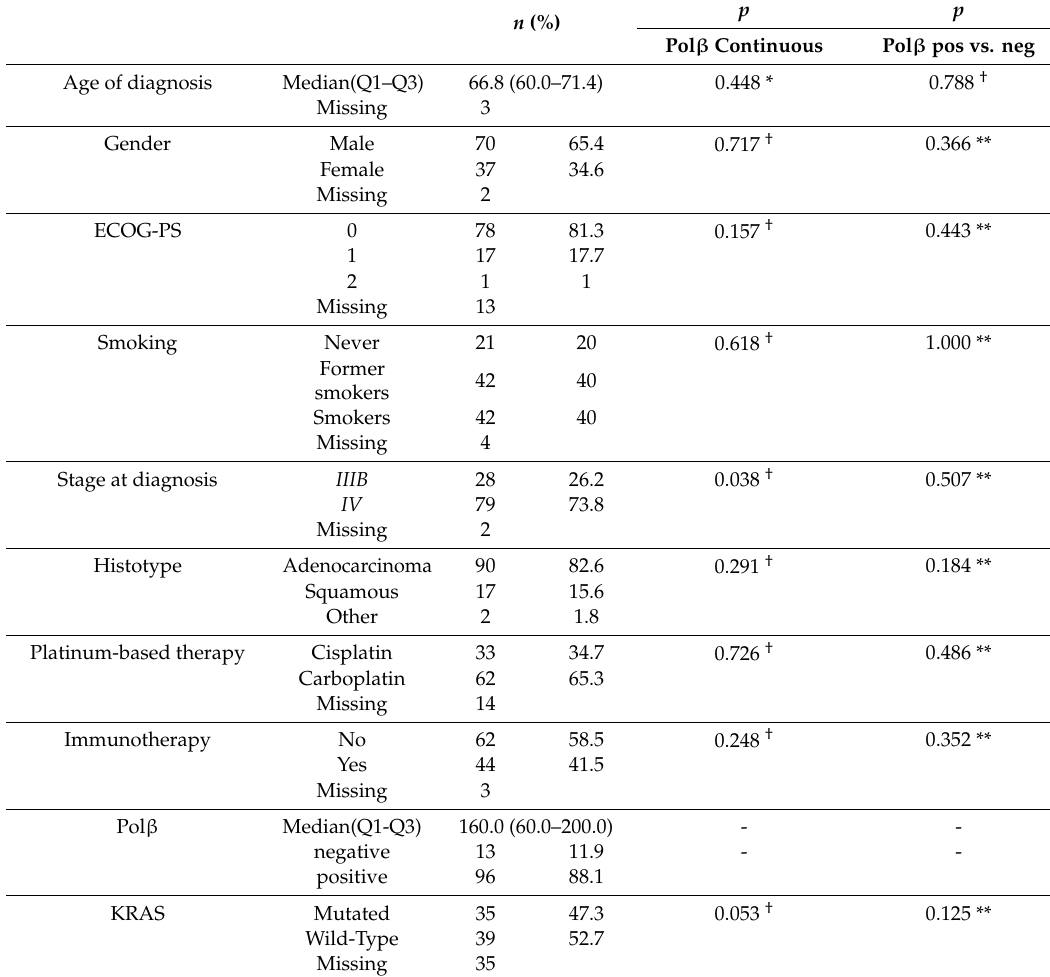
Table 1. Baseline characteristics of patients ( n = 109) and their relation with Pol β as a continuous or dichotomous variable. Pos, positive; neg, negative.